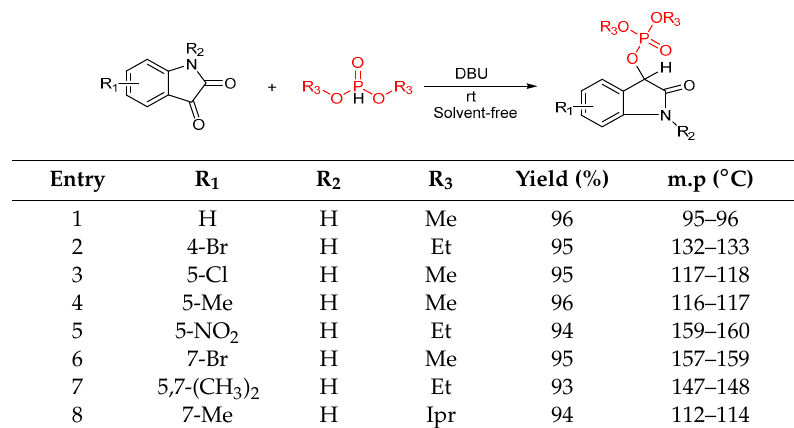
Table 3. The synthesis of isatin-based α -Phosphate Amide derivatives b .